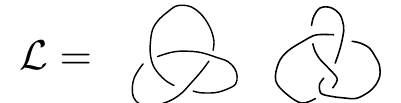
Figure 3 . When L = K 1 t K 2 with K 1 (here the trefoil 3 1 ) and K 2 (here the figure eight 4 1